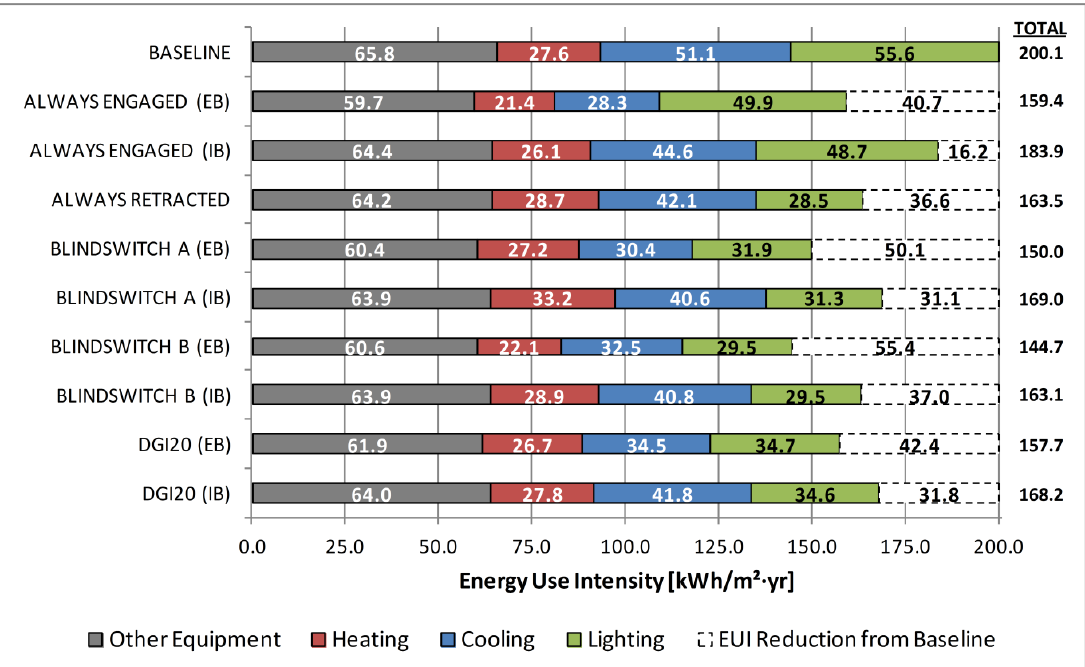
Figure 21. Annual end-use energy consumption comparison of interior (IB) and exterior blind (EB)